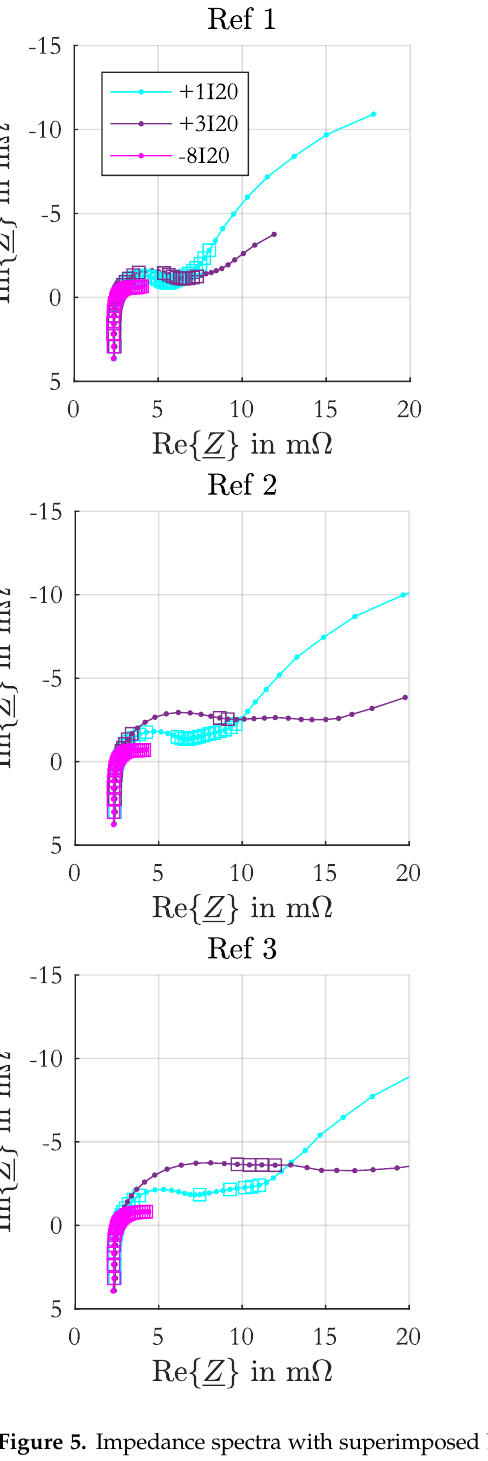
Figure 5. Impedance spectra with superimposed DC-currents of + 1 I 20 , + 3 I 20 and − 8 I 20 performed during the reference measurements and measurements with stratified acid presented as Nyquist-diagrams. The squares in the diagrams mark the impedance values, which passed the zHit